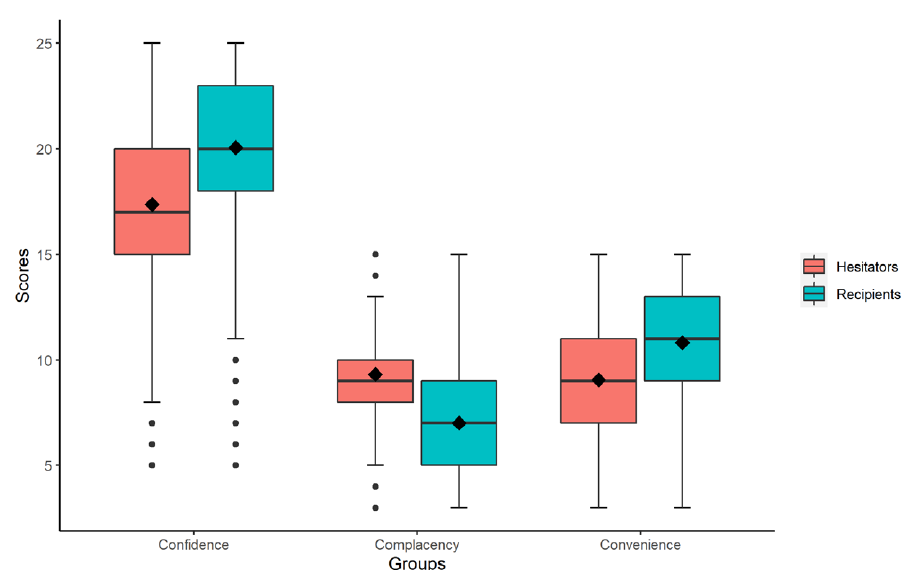
Figure 3. Box plots of dimensional scores of the “3C” model for different IVH subgroups. Multivariate logistic regression results (Table 3) showed that for sociodemographic characteristics, mothers (OR: 1.506, 95% CI: 1.252–1.813), household registration of other provinces (OR: 0.739, 95% CI: 0.618–0.884), bachelor’s degree or equivalent (OR: 2.126,